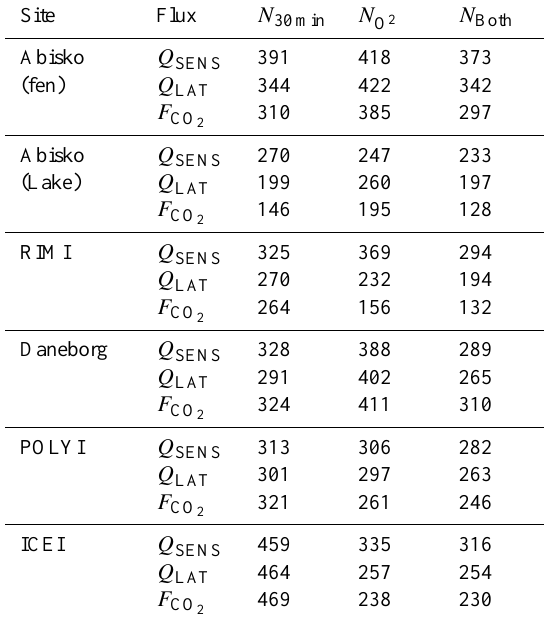
Table 1. Number of flux estimates from the conventional method ( N 30min ) , the ogive optimization method ( N combined pairs of estimates ( N Both ) used to determine the relative flux-estimate differences illustrated in Fig.